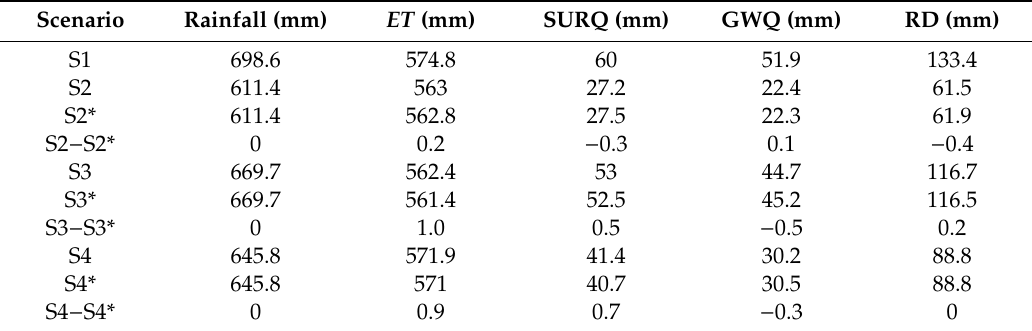
Table 4. Water balance components and the di ff erence between paired